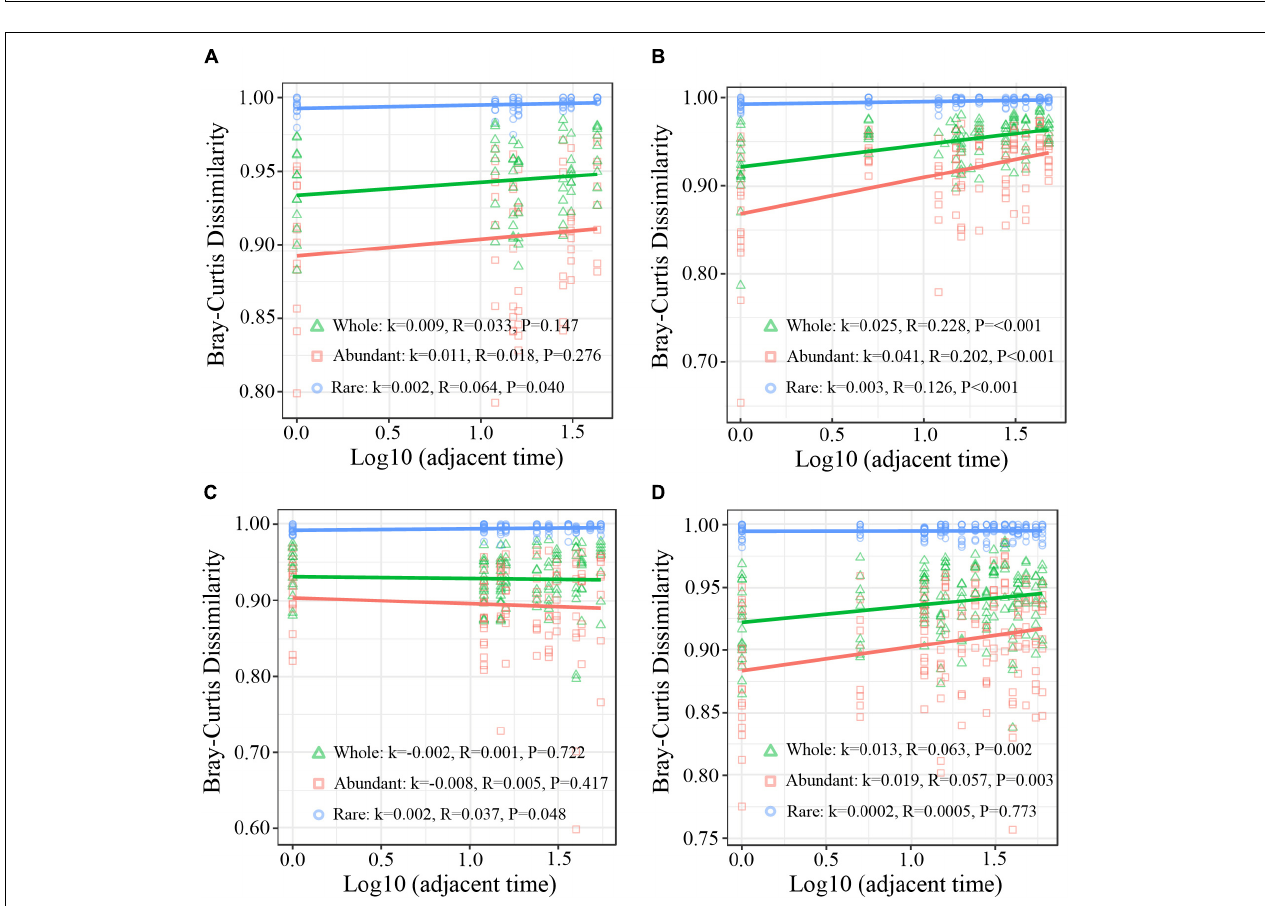
FIGURE 2 | Principal coordinate analysis (PCoA) of the bacterial communities based on the Weighted Unifrac distance. (A) B sediment (B) P sediment. CON, the control group; INV, the invasion group.